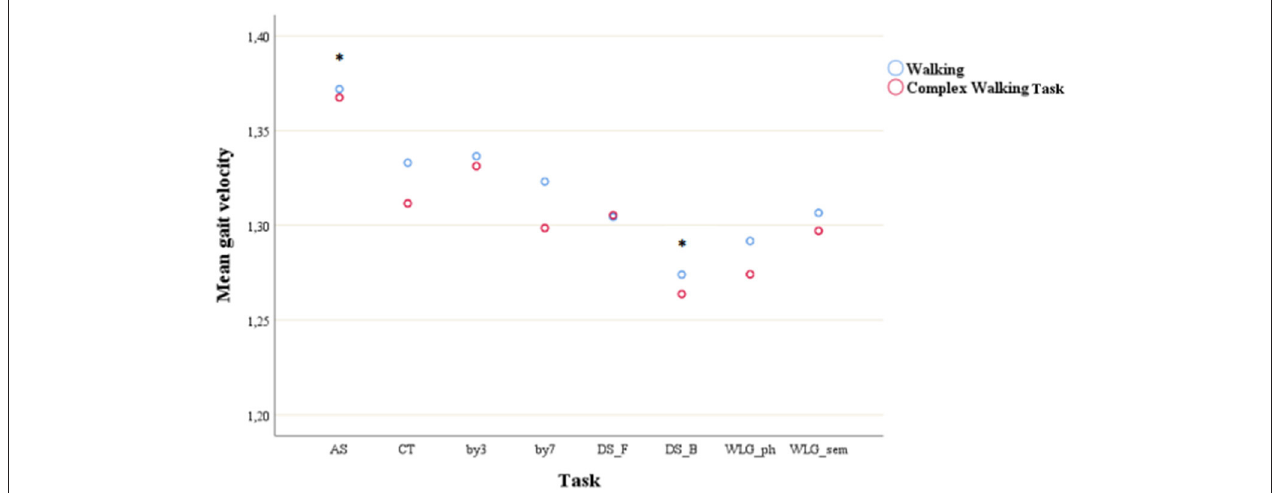
FIGURE 2 | Mean gait velocity during simple walking and complex walking task across cognitive tasks. * post-hoc test showed significant difference with all the other tasks. AS, auditory stroop; CT, clock test; by3, subtracting by3; by7, subtracting by7; DS_F, digit span forwards; DS_B, digit span bacwards; WLG_ph, word list generation phonemic; WLG_sem, world list generation semantic.